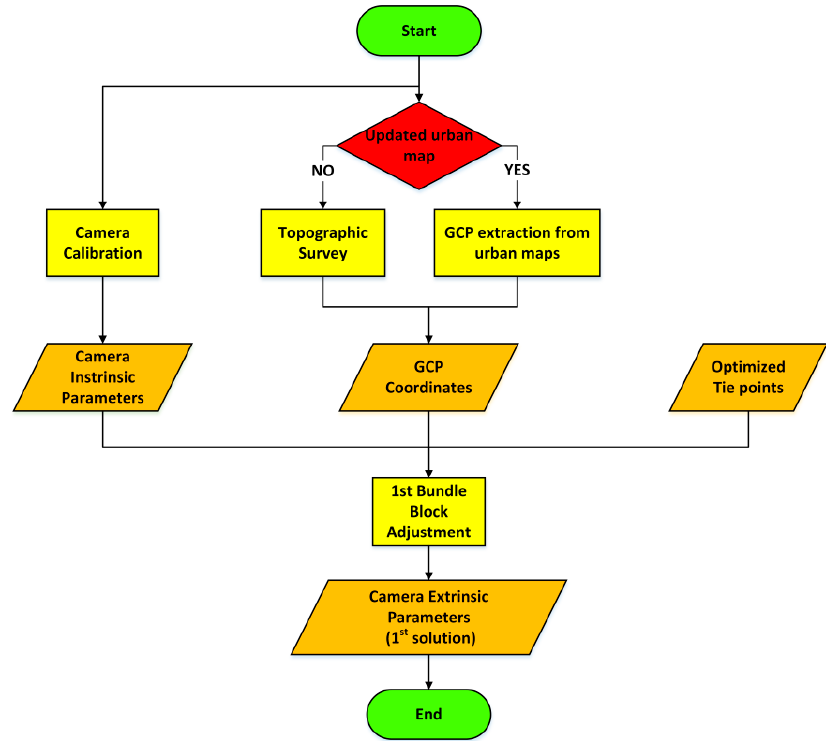
Figure 2. Methodological workflow of the first approximate bundle block adjustment.